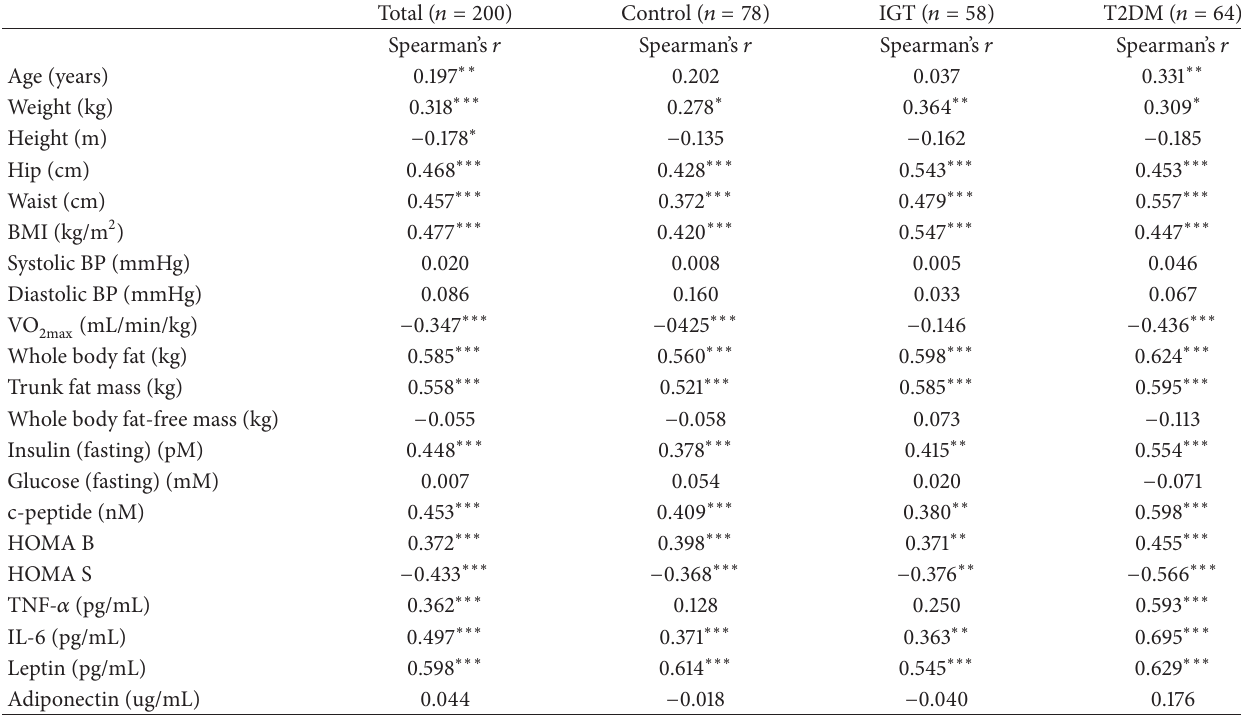
Table 2: Correlation between plasma follistatin-like 3 and demographic and biochemical